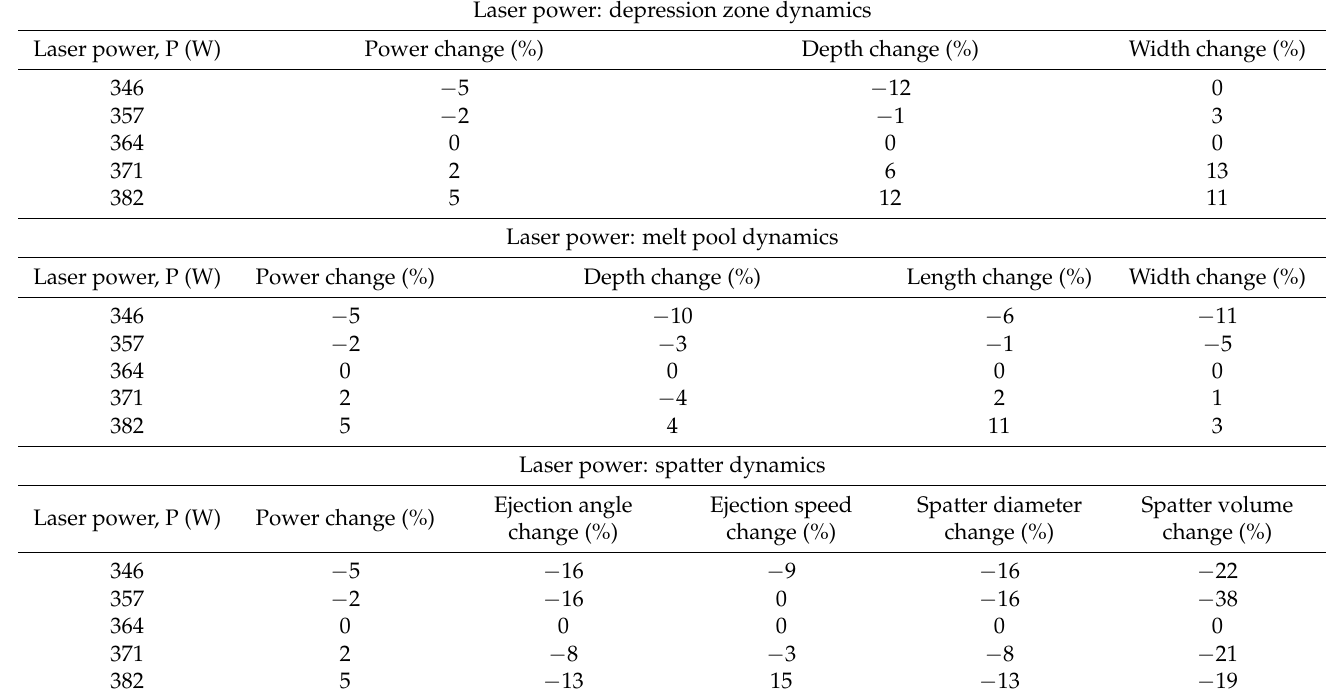
Figure 6. Effects of laser power variation on SLM dynamics for Ti6Al4V. ( a , b ) Changes in the depression zone depth and width due to variation in the laser power. ( c – e ) Changes of the melt pool depth, length, and width due to variations in laser power. ( f – i ) Changes of the spatter average direction, speed, diameter, and total volume due to variation in the laser power. All testing is conducted using 15–25 µ m, plasma atomized Ti6Al4V powder. Table 4. Percent change in SLM dynamics induced by variations in laser power during scanning. Laser power: depression zone